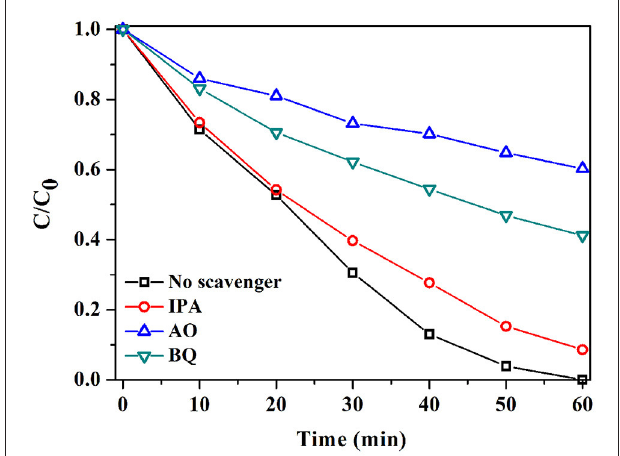
FIGURE 8 | Radical-scavenge tests in the degradation of RhB over S3.